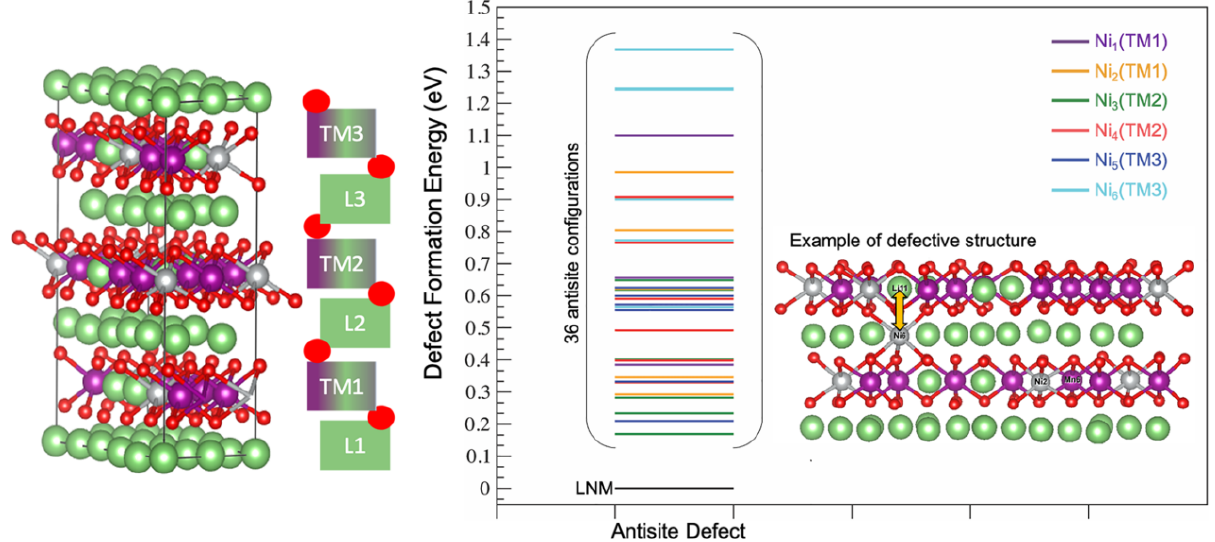
Figure 3. Defect formation energy for all defective LNM configurations. An example of a Ni/Li antisite switch is shown between a nickel atom in the TM layer and a Li atom in the Li layer.